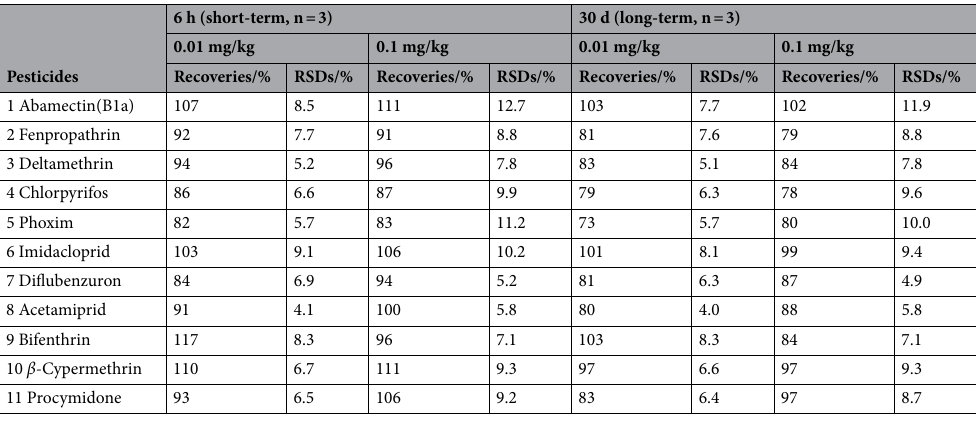
Table 2. The stability test results of 11 pesticides in apricot under two storage conditions (n = 3).